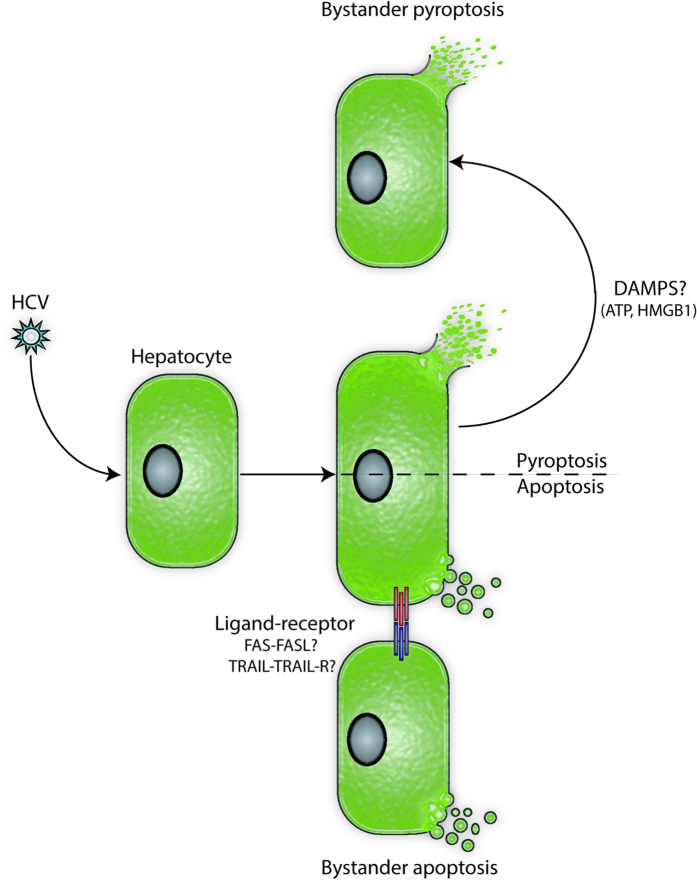
Proposed model for HCV-induced programmed cell death.Schematic representation of the proposed model for the induction of the multiple forms of PCD in response to HCV infection. HCV infection induces at least two forms of programmed cell death in the infected cells: apoptosis and pyroptosis. Apoptosis is also induced in the neighbouring uninfected cells (bystander apoptosis) in a cell-cell contact-dependent manner, presumably by an interaction between a death ligand expressed on the surface of infected cell and a death receptor expressed on the surface of the bystander cell. The induction of bystander pyroptosis is cell-cell contact independent and is mediated by an as yet undetermined soluble factor.